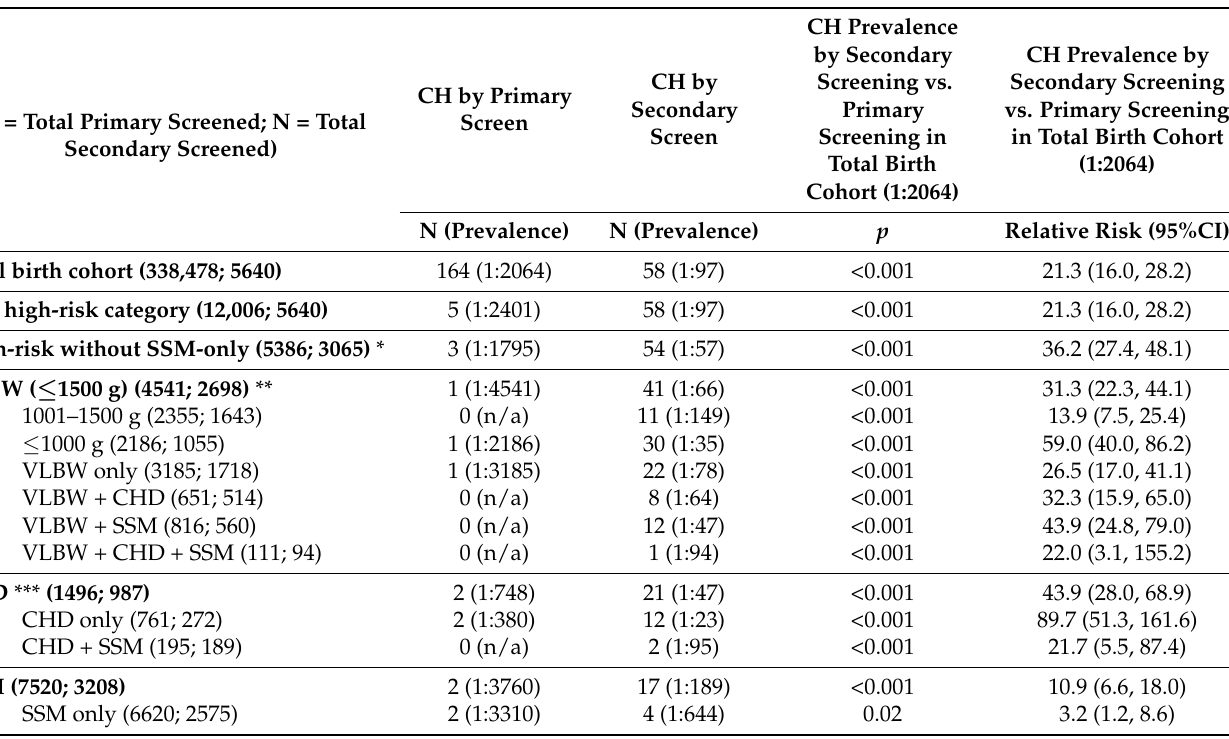
Table 3. Congenital hypothyroidism (CH) cases with relative risk of CH diagnosis by secondary screen for each high-risk category compared to the risk of CH diagnosis found by primary screening for the total birth cohort.